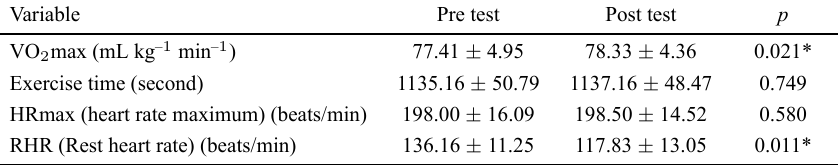
Table 4. Change in exercise performance (Mean Values ± SD).